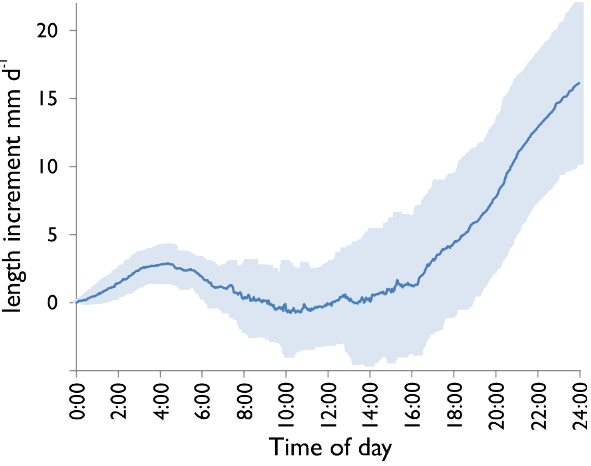
Fig. 6. The measured average shoot length increment diurnal pat- tern of a Scots pine shoot outside the enclosure under unshaded conditions during 12days, with moderate elongation rate in sum- mers 2010 and 2011. The shoot length at the beginning of day is set to 0. The shaded area represents ± 1 standard deviation in shoot